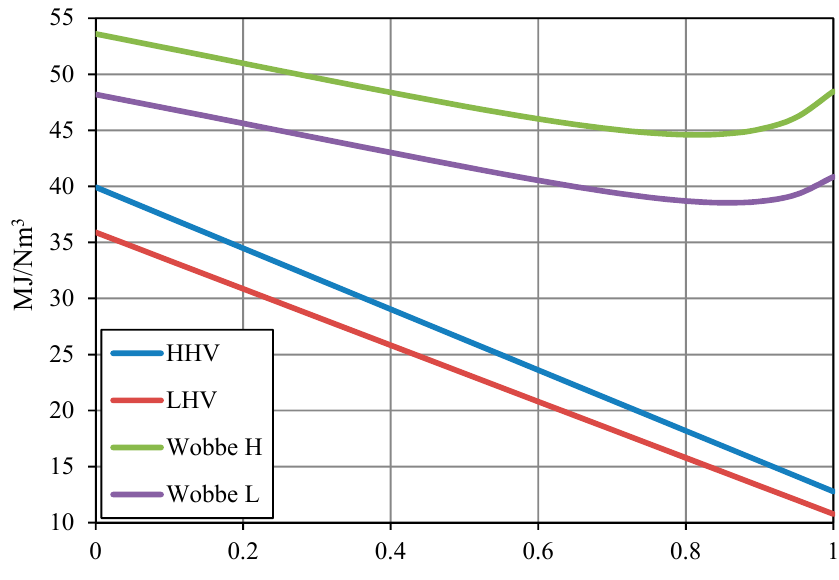
Figure 13. Changes of higher heating value (HHV), lower heating value (LHV) and Wobbe indexes as a function of hydrogen molar fraction in mixture with methane.